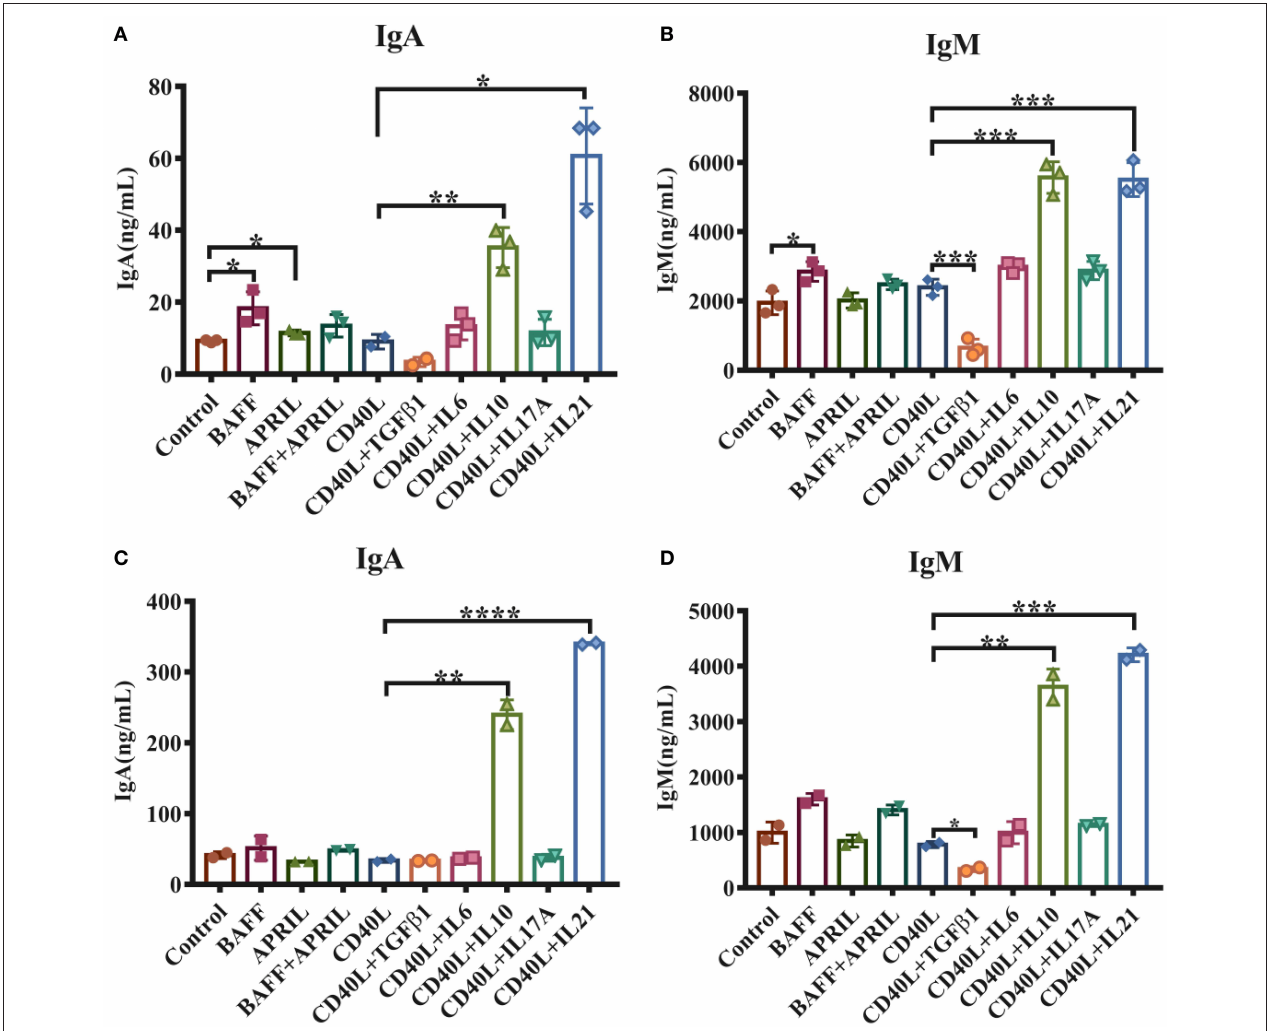
FIGURE 1 | IL-21 increases IgA secretion in IgM + B cells from porcine PPs and MLNs. IgM + B lymphocytes from porcine Peyer’s patches and MLNs were isolated and cultured with the indicated factors and cytokines for 5–6 days. The IgA and IgM levels secreted by porcine IgM + B cells from Peyer’s patches (A,B) and MLNs (C,D) were measured by ELISA. Experiments were performed independently in duplicate and triplicate. * p ≤ 0.05; ** p ≤ 0.01; *** p ≤ 0.001; **** p ≤